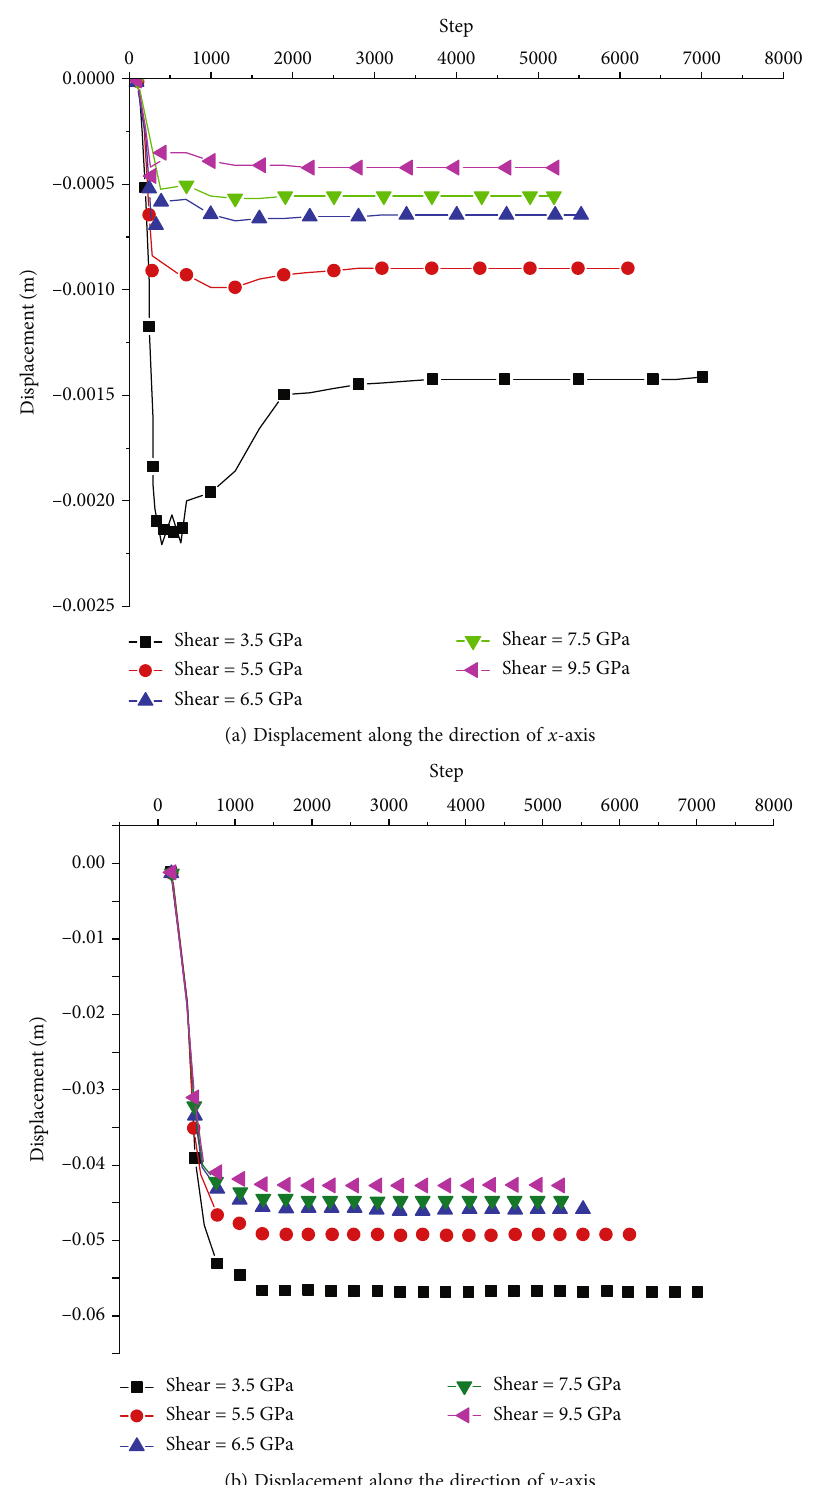
Figure 12: Displacement magnitude under the condition that the shear modulus is di ff